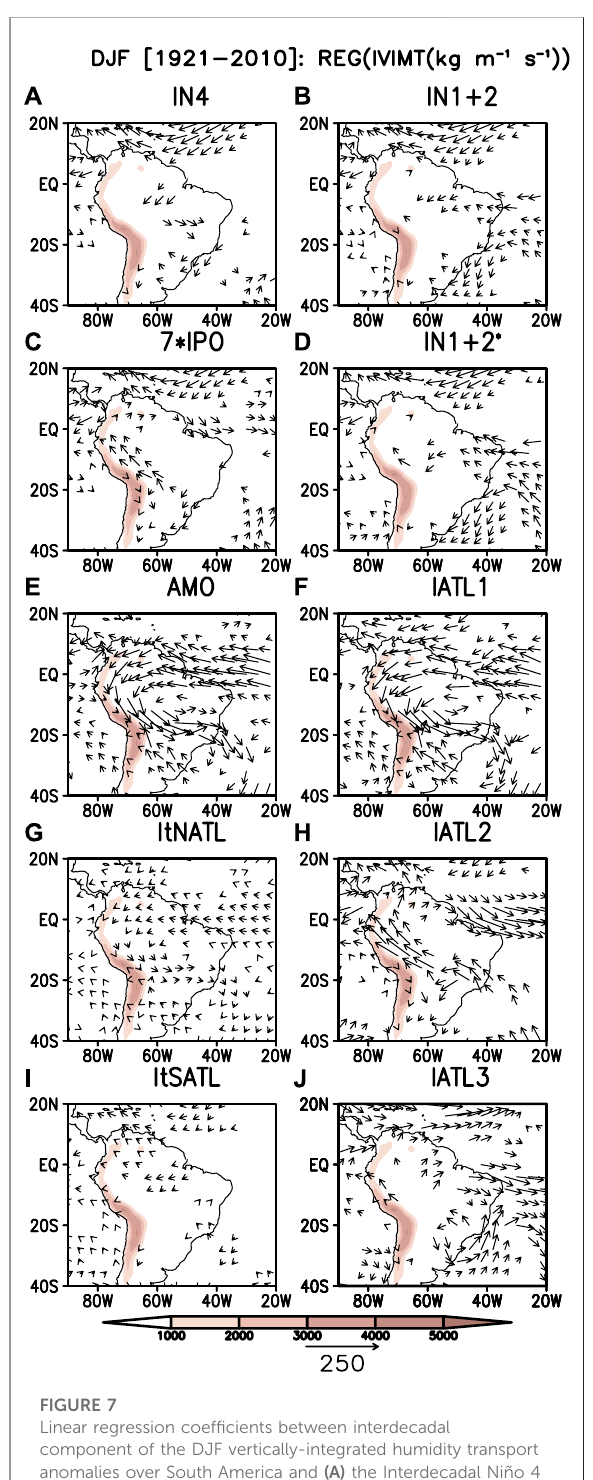
FIGURE 7 Linear regression coef fi cients between interdecadal component of the DJF vertically-integrated humidity transport anomalies over South America and (A) the Interdecadal Niño 4 (IN4), (B) Interdecadal Niño 1 + 2 (IN1+2) index, (C) Interdecadal Paci fi c Oscillation (IPO), (D) Interdecadal Niño 1 + 2 with Interdecadal Niño 4 removed (IN1+2*), (E) Atlantic Multidecadal Oscillation (AMO), (F) fi rst rotated principal component of the interdecadal variability of the Atlantic SST (IATL1), (G) Interdecadal tropical North Atlantic (ItNATL) index, (H)